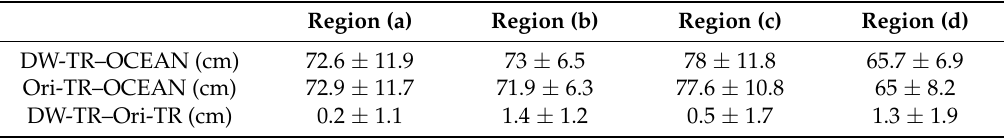
Table 5. Mean biases with standard deviation between retracked SSHs by DW-TR, Ori-TR and OCEAN. Biases were estimated using along-track points within the 13–20 km band where correlation coefficient with tide gauge was higher than 0.9 for the three retrackers and for the four